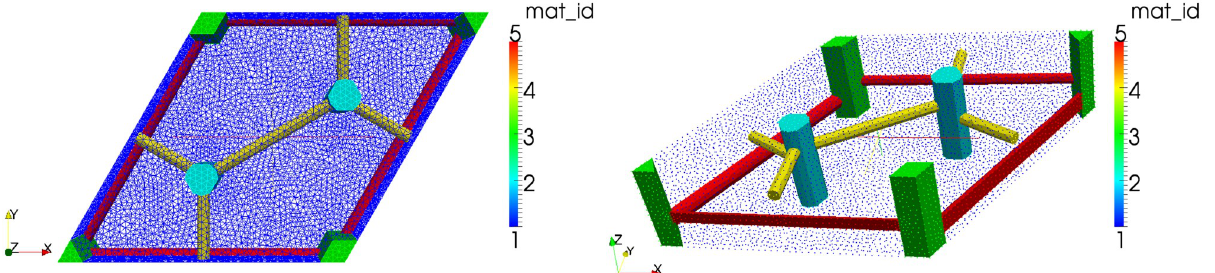
Fig 7. Finite element mesh of the LRPC (right). Decomposition of domain Y (left).